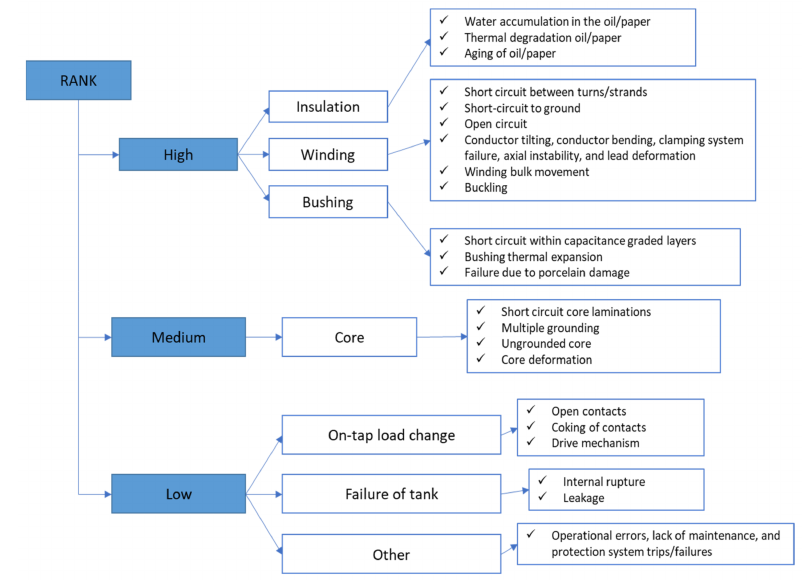
Figure 3. Ranking of transformer components